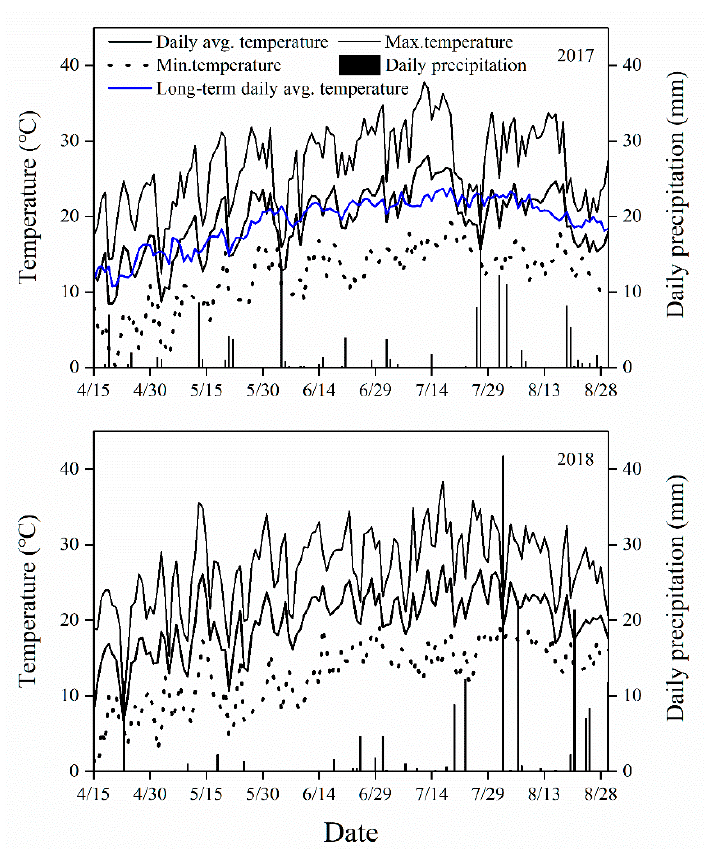
Figure 1. Long-term daily average air temperature from 2008 to 2018, daily average air temperature, daily maximum air temperature, daily minimum air temperature and daily precipitation in 2017 and 2018 at Wuwei, China. Table 1. Daily average air temperature ( 𝑇 (cid:3028) ), minimum air temperature ( 𝑇 (cid:3040)(cid:3036)(cid:3041) ), maximum air temperature ( 𝑇 (cid:3040)(cid:3028)(cid:3051) ), days of minimum temperature below 10 °C, days of maximum temperature above 30 °C, precipitation days and precipitation amount during each potato growth stage in 2017 and 2018 at Wuwei, China.